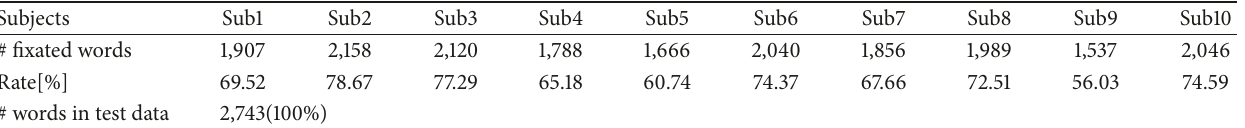
Table 2: Baseline rates for fixated words in the test data.